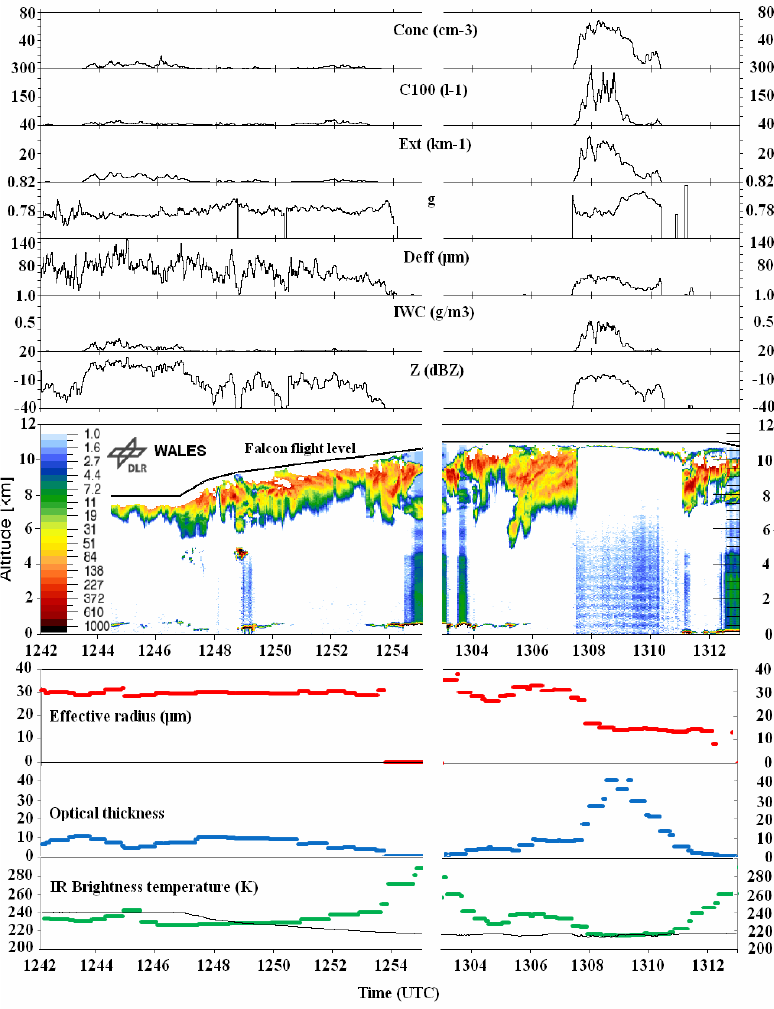
Fig. 6. 1st panel : Time-series of cloud in situ parameters: Conc and C100 : Concentration of ice particles ( d > 3 µm and d > 100